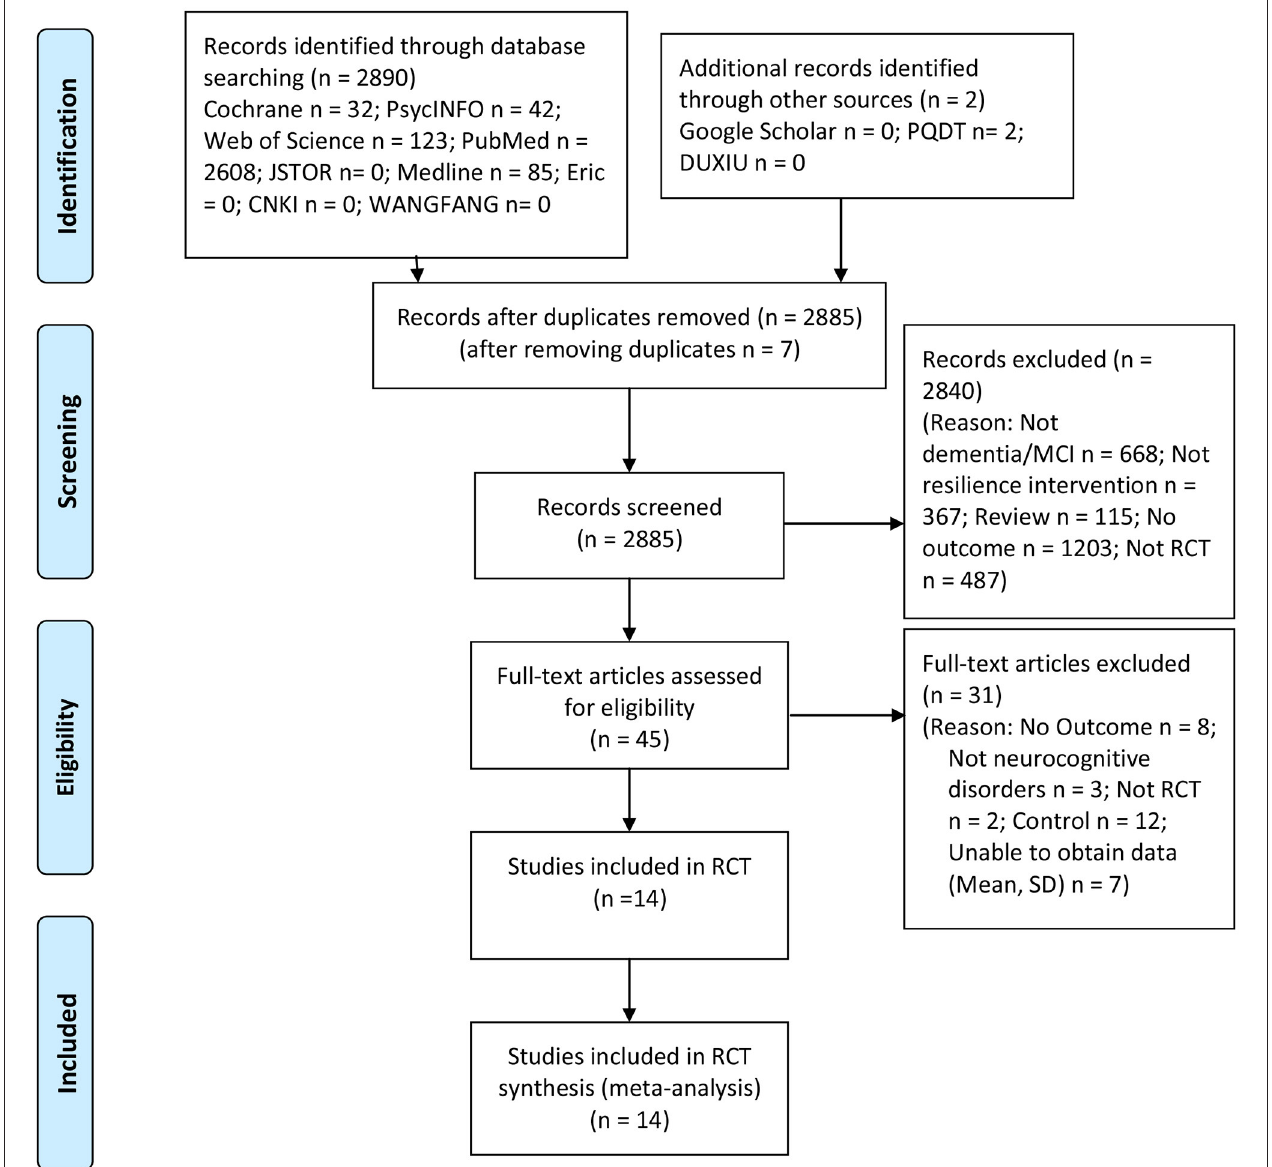
FIGURE 1 | Flowchart of the study selection